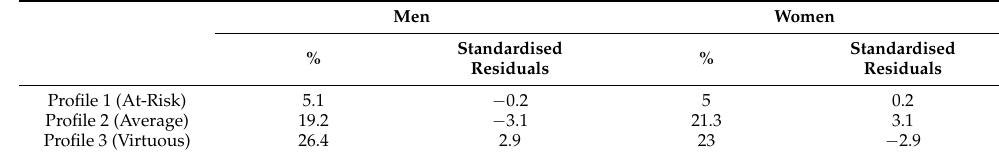
Table 3. Gender Differences in Profile Membership Distribution.